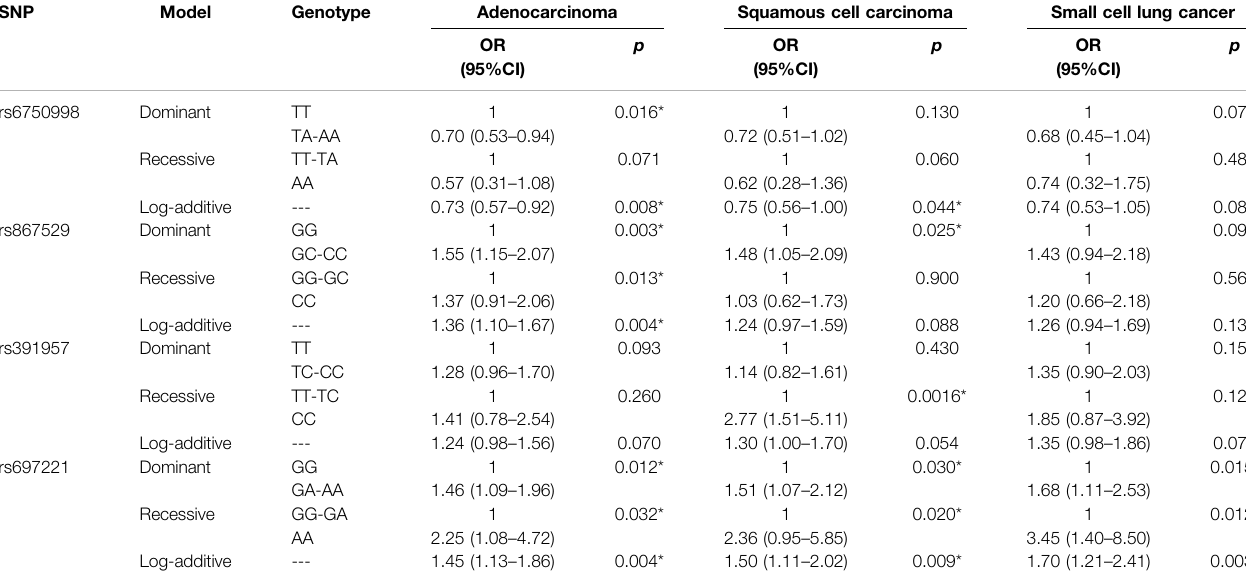
TABLE 7 | Association between SNPs and risk of adenocarcinoma, squamous cell carcinoma, and small-cell lung cancer. SNP